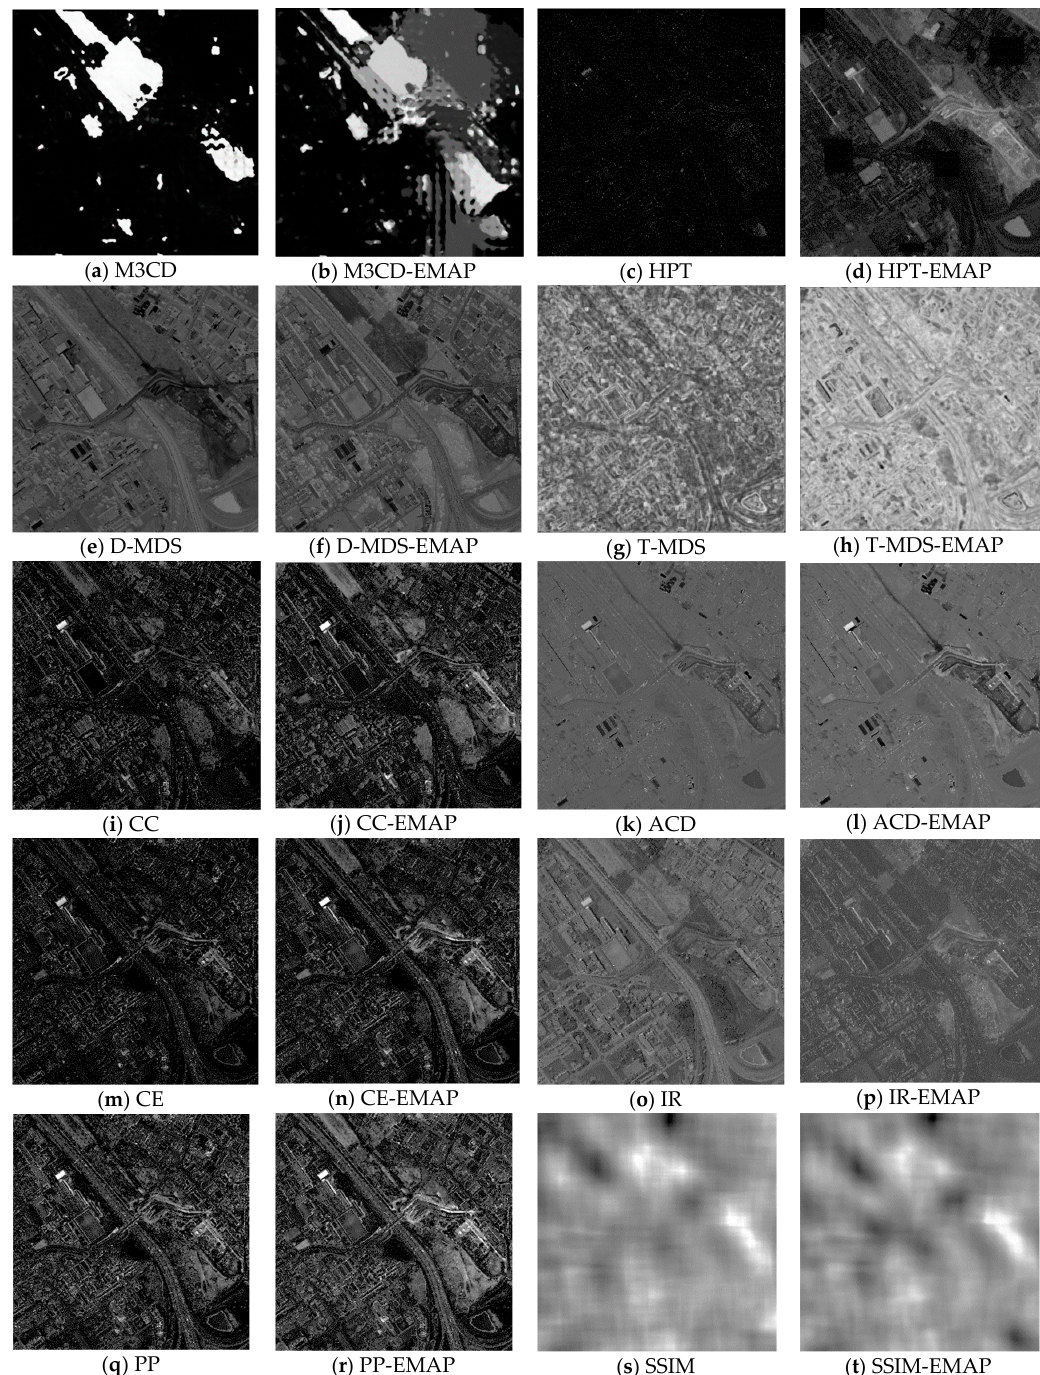
Figure 21. Ground truth and change detection score image for the best performing method (Image Pair-5).